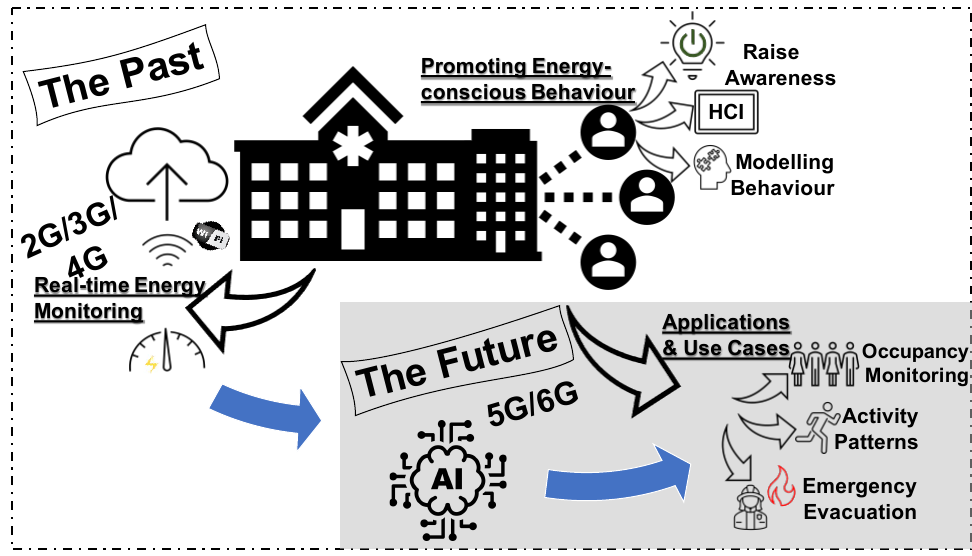
Figure 9. Smart utility monitoring for energy-saving systems—the past and the future.